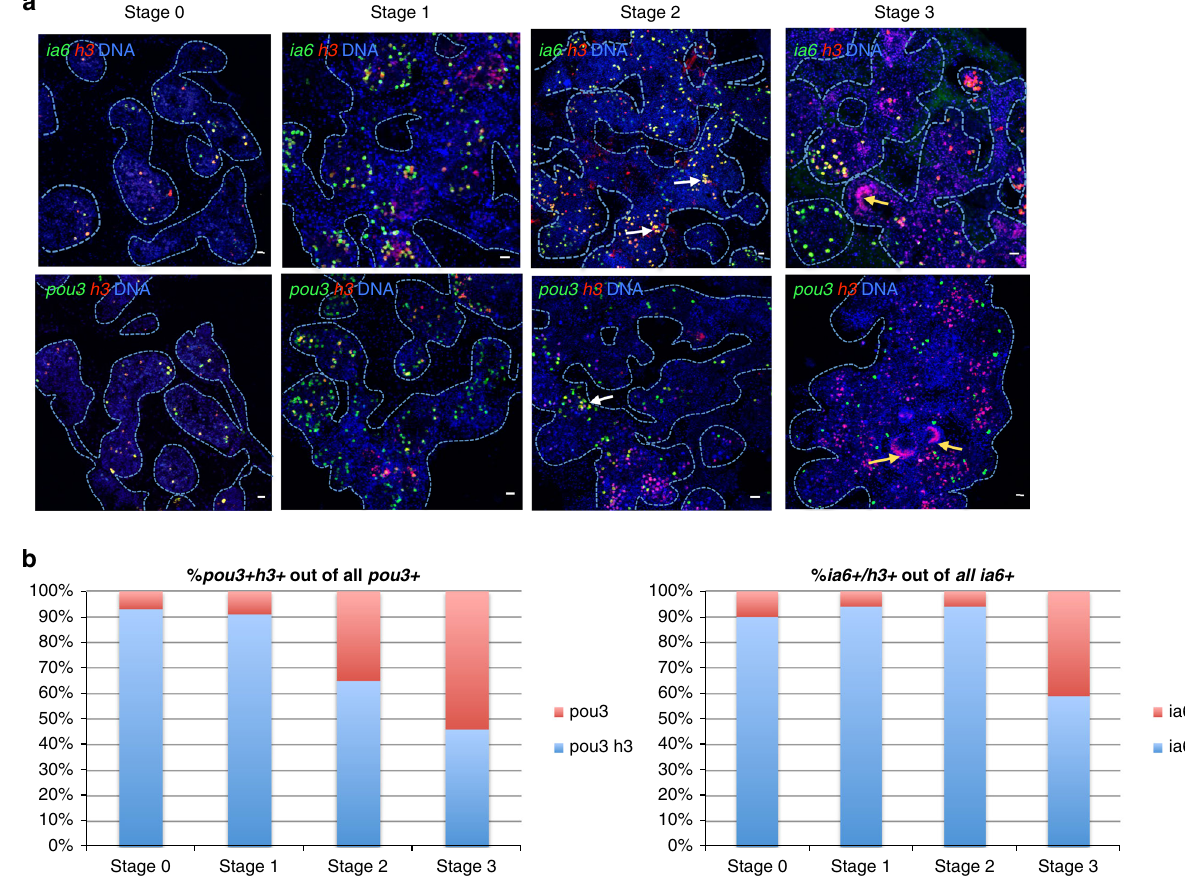
Fig. 2 Whole body regeneration is associated with proliferation of blood-borne integrin-alpha-6 + cells. a Fluorescent in situ hybridization (FISH) showing expression of integrin-alpha-6 ( ia6 , green) and histone 3 ( h3 , red) during stages 0, 1, 2, and 3 of WBR. White arrows indicate ia6 + cells beginning to cluster during stage 2. As clusters increase in size, they begin to lose ia6 expression. As cell clusters differentiate to form the blastula-like structure, ia6 expression is not detected (yellow arrows). DNA was stained with Hoechst (blue) in all panels. Blue dashed lines outline blood vessel boundaries. Images are representatives of four independent experiments. Scale bars 20 μ m. b Single-positive ( ia6, pou3 , or h3 ) and double-positive ( ia6 / h3 or pou3 / h3) cells were counted using the cell counter feature in FIJI, and for each stage, four images from four independent samples were counted. Graph shows percentages of ia6/h3 double-positive or pou3/h3 double-positive cells among all ia6 + or pou3 + cells. Source data are provided as a Source Data fi